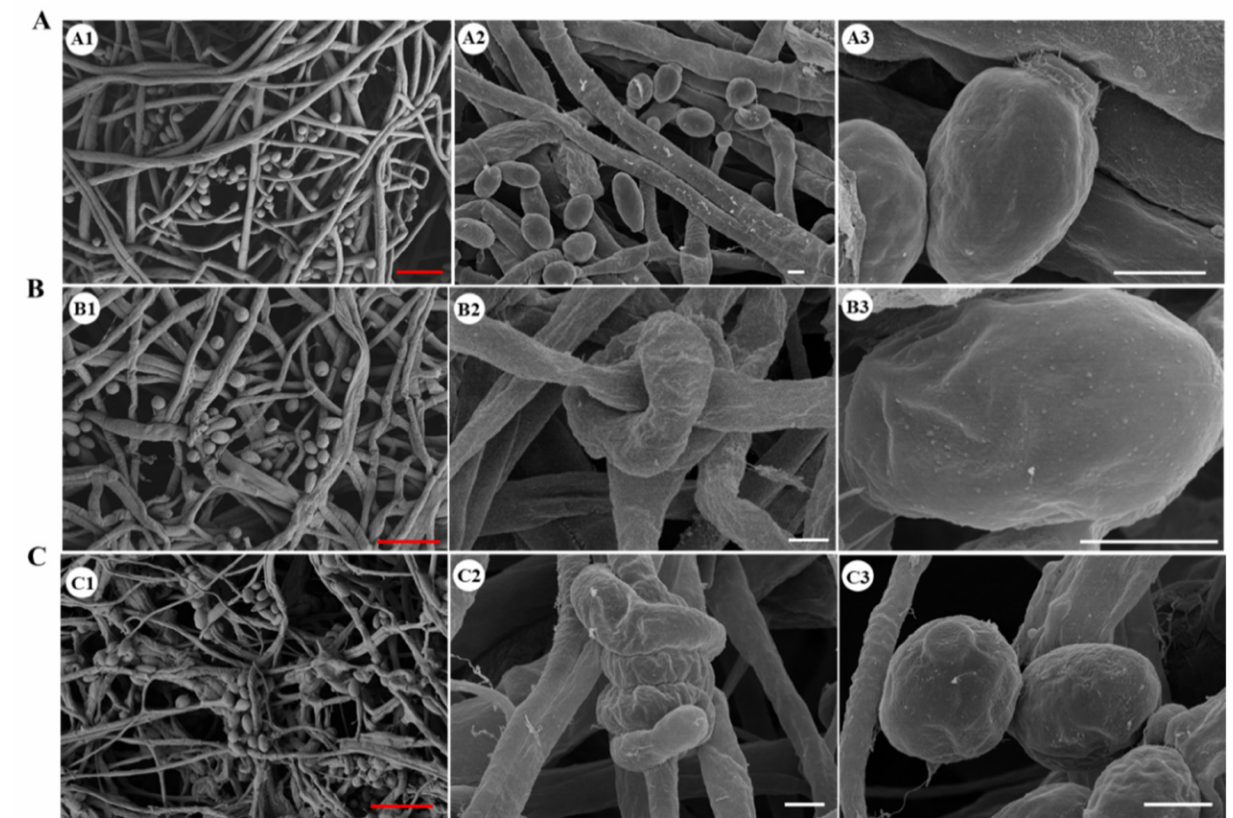
Figure 2. Conidia and hyphae of WT and mutant strains observed by SEM. ( A ) WT strain. ( B ) ∆ Cmhyd1 strain. ( C ) ∆ Cmarea strain. Bars: A1, B1, C1 = 1 µ m; others = 10 µ